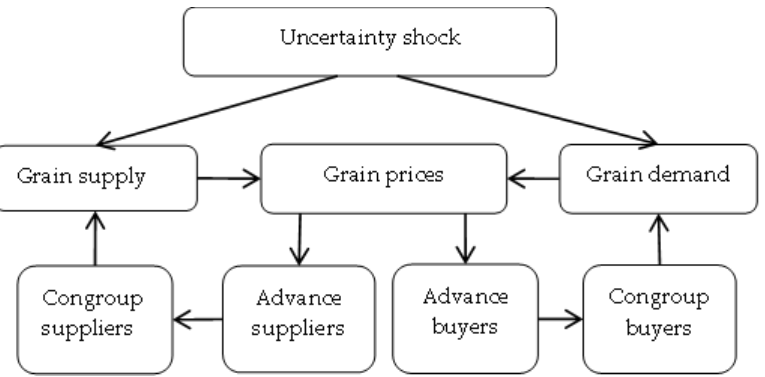
Figure 2. Transmission path of the impact of uncertainty shock on grain price changes. Sources: The picture is drawn by the author by analyzing the impact of uncertainty on grain prices.